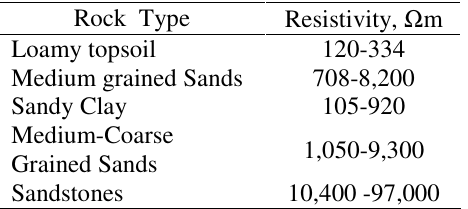
Table 2. Ranges for resistivity of rocks in the